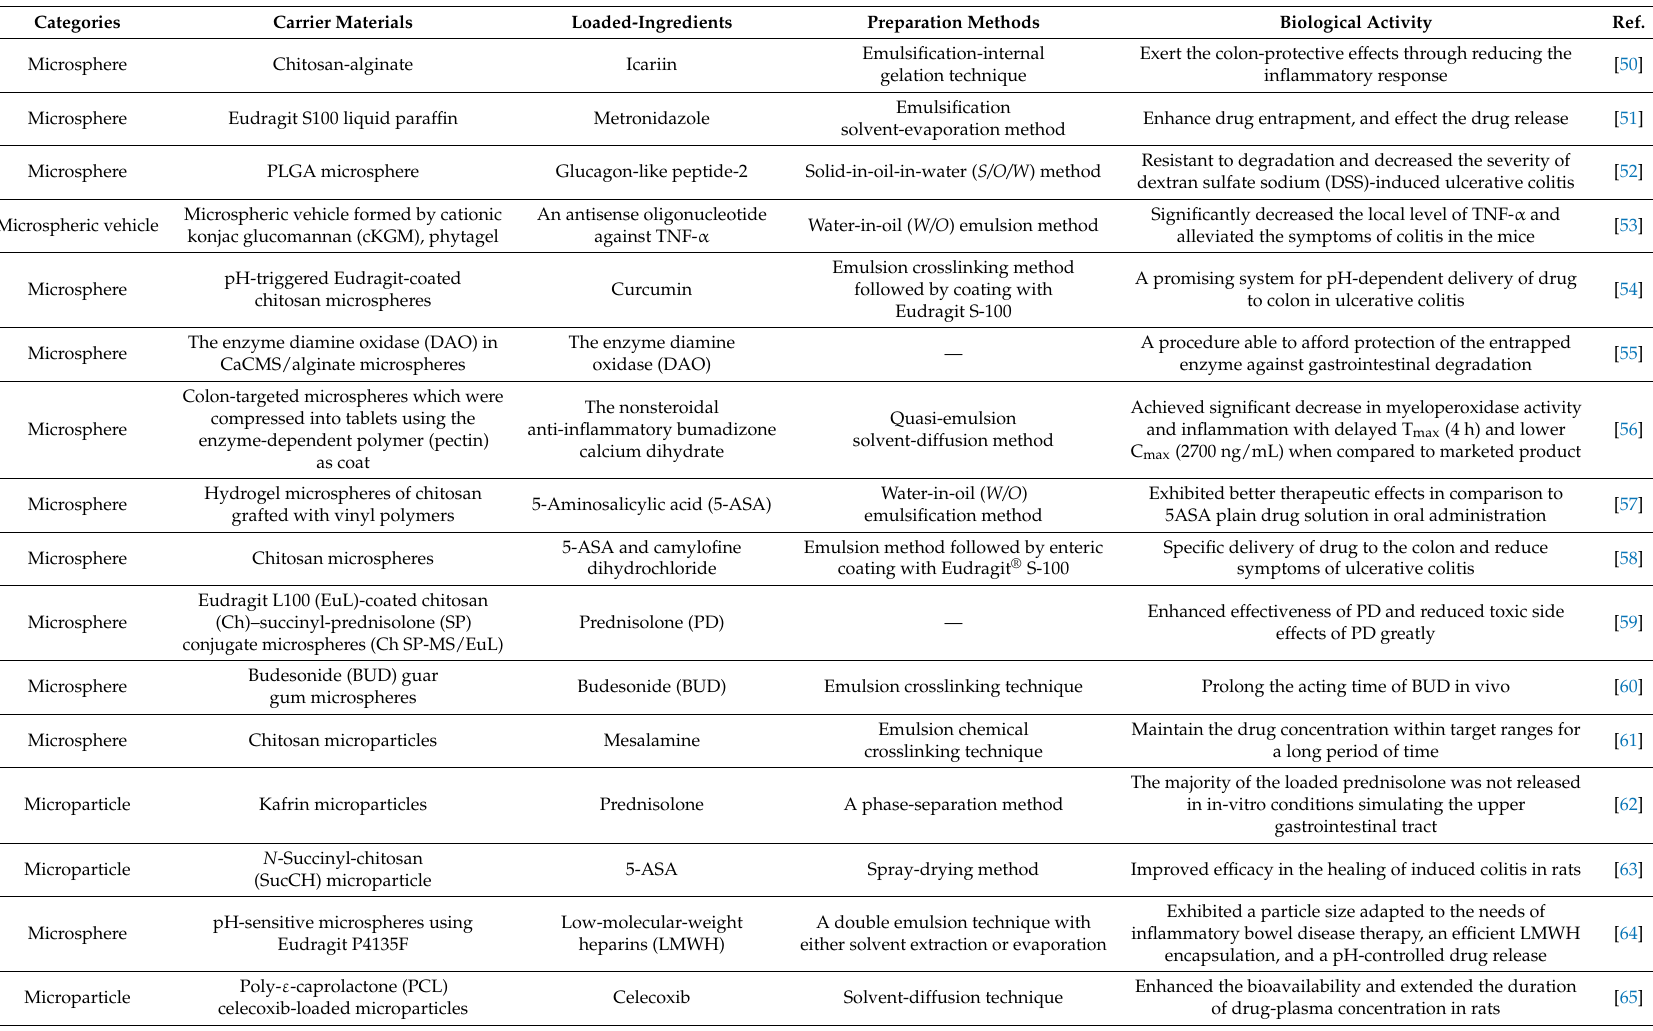
Table 2. Studies on the formula, preparation method and biological activity of different microparticles in treating